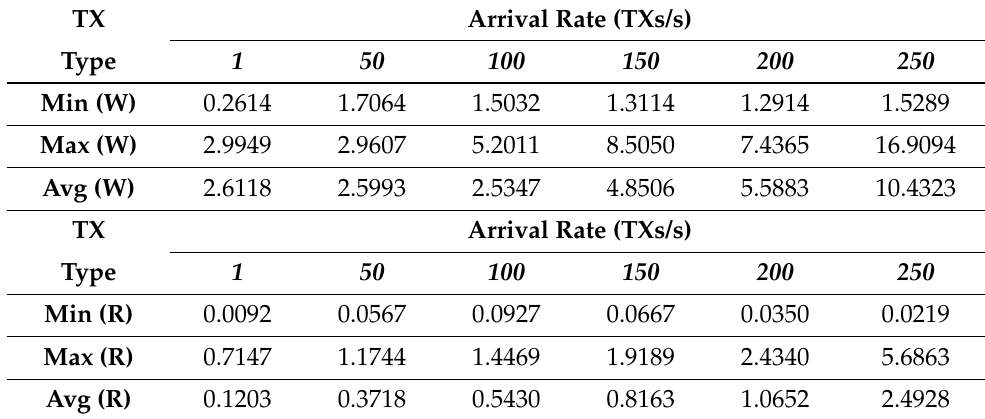
Table 2. Latency measures, in seconds, for read (R) and write (W) TXs where network size =